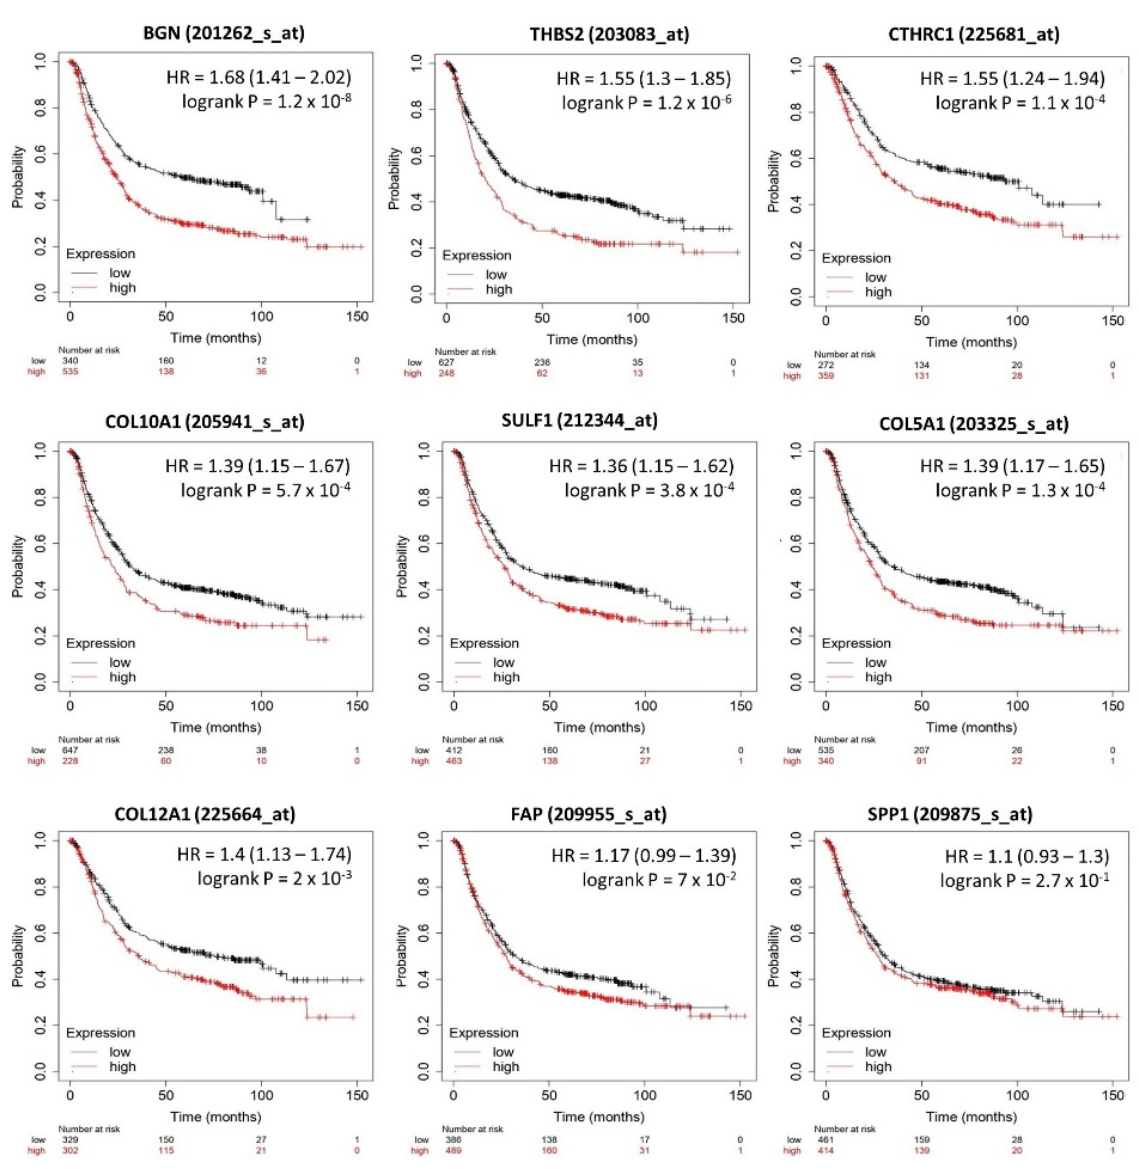
Figure 5. Overall survival curves according to high and low DEG expression. High gene expression has a higher hazard ratio (HR) for poor overall survival.